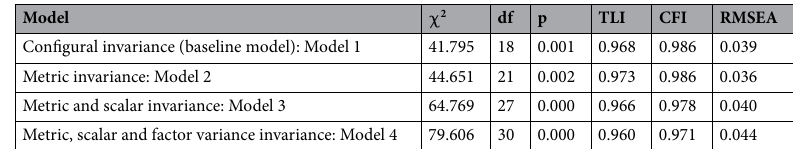
Table 3. Fit indices for invariance tests.